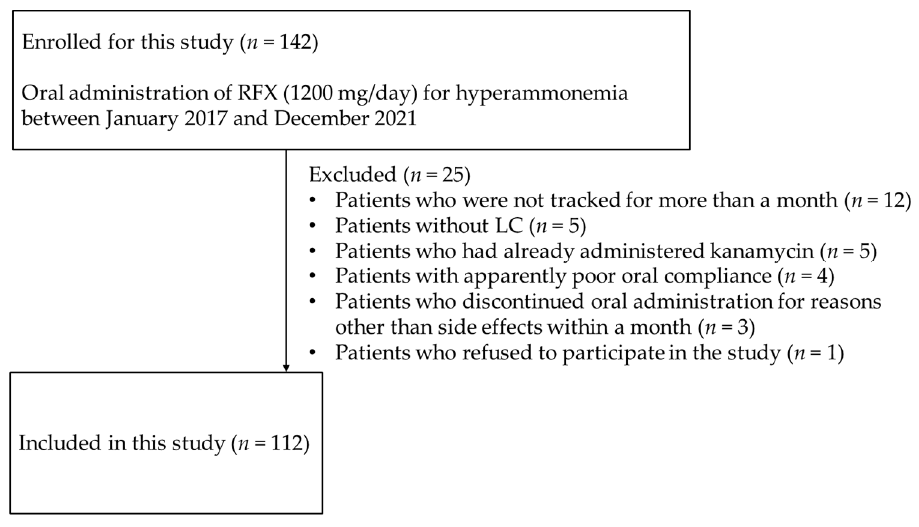
Figure 1. Flowchart illustrating patient selection for the study. n , number; RFX, rifaximin.